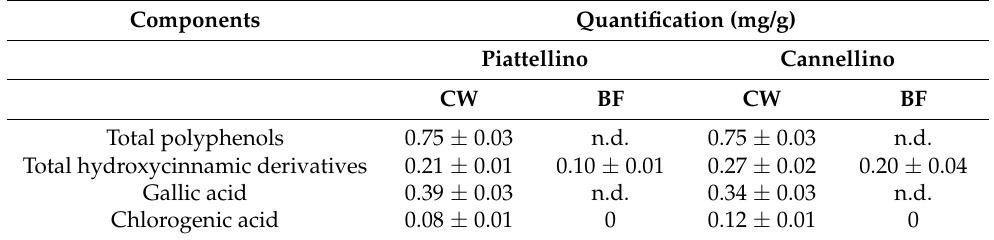
Table 1. Polyphenol content of CW and BF extracts of Cannellino and Piattellino